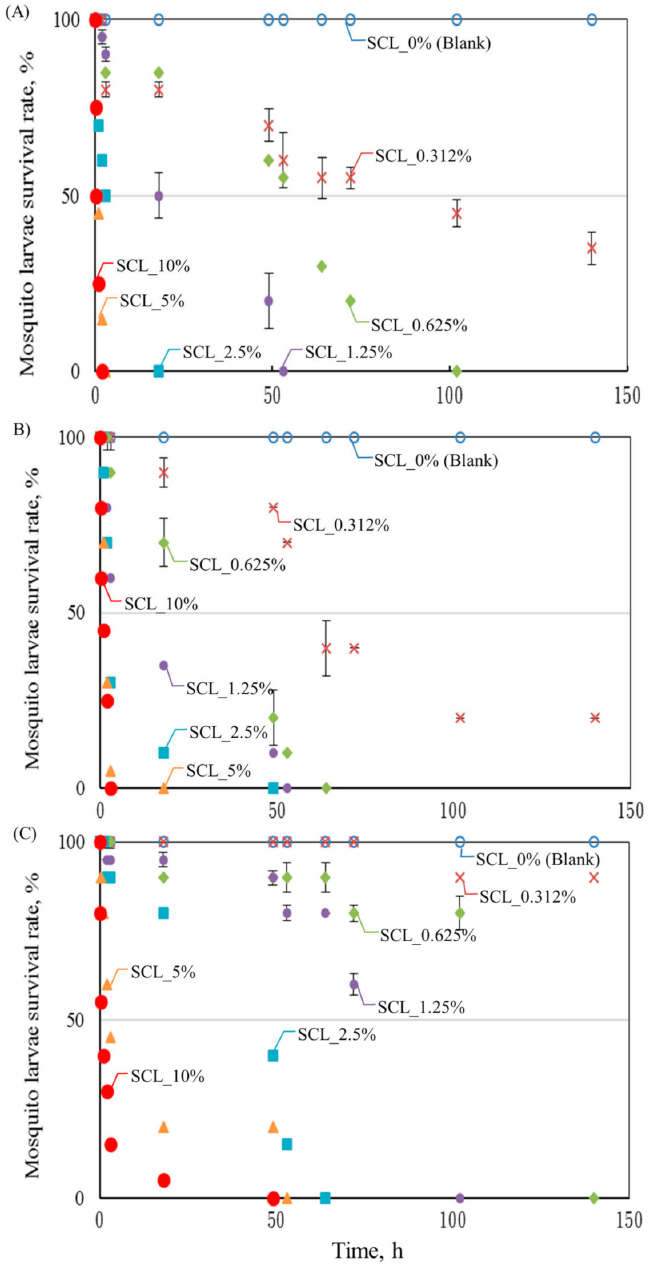
Figure 6. Plots of larval survival rates overtime at various concentrations (i.e., 0.312–10%) of ( A ) date, ( B ) pomelo, and ( C ) guava SCLs. Each sample was triplicated with values = mean ± std. dev. (n = 3). For clarity, some data were given as mean values